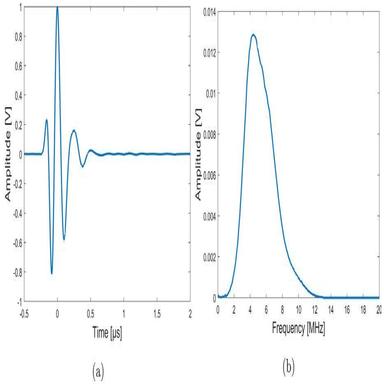
(a) Cross-section of the lower hemisphere (radius R) of the UPS technique along a fixed in plane angle showing the ray path of a wave with incidence angle θ. The dashed and dotted line correspond respectively to the physical path and the path (Df) of the simulated wave. (b) Cross-section of an aluminum TOF P-UPS experiment at a certain in-plane angle ϕ: experimental recording (black), corrected simulation result (red) and uncorrected simulation result (blue).